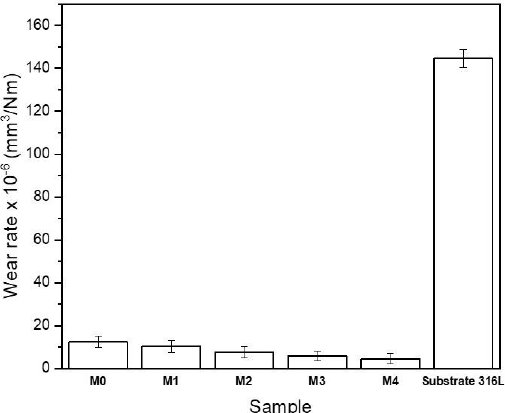
Figure 8. Wear rate of the coatings and the